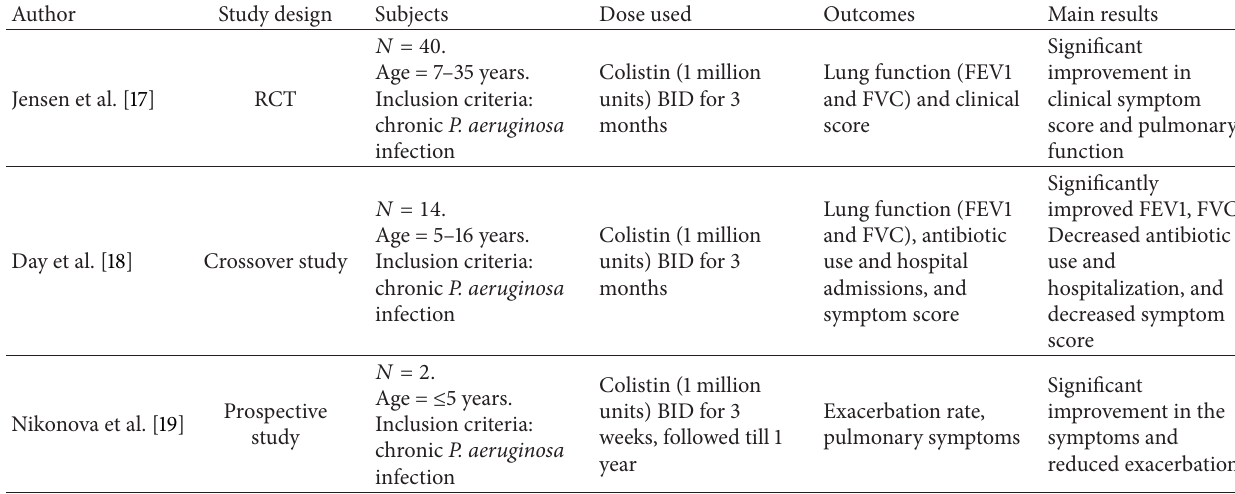
Table 3: Summary of inhaled colistin